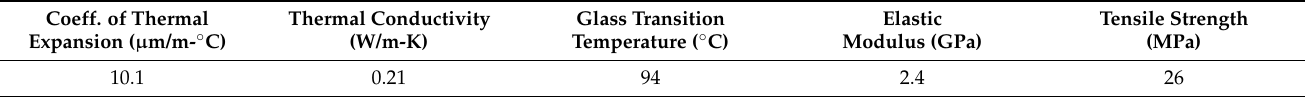
Table 2. Primary physical and mechanical properties of ABS at room temperature